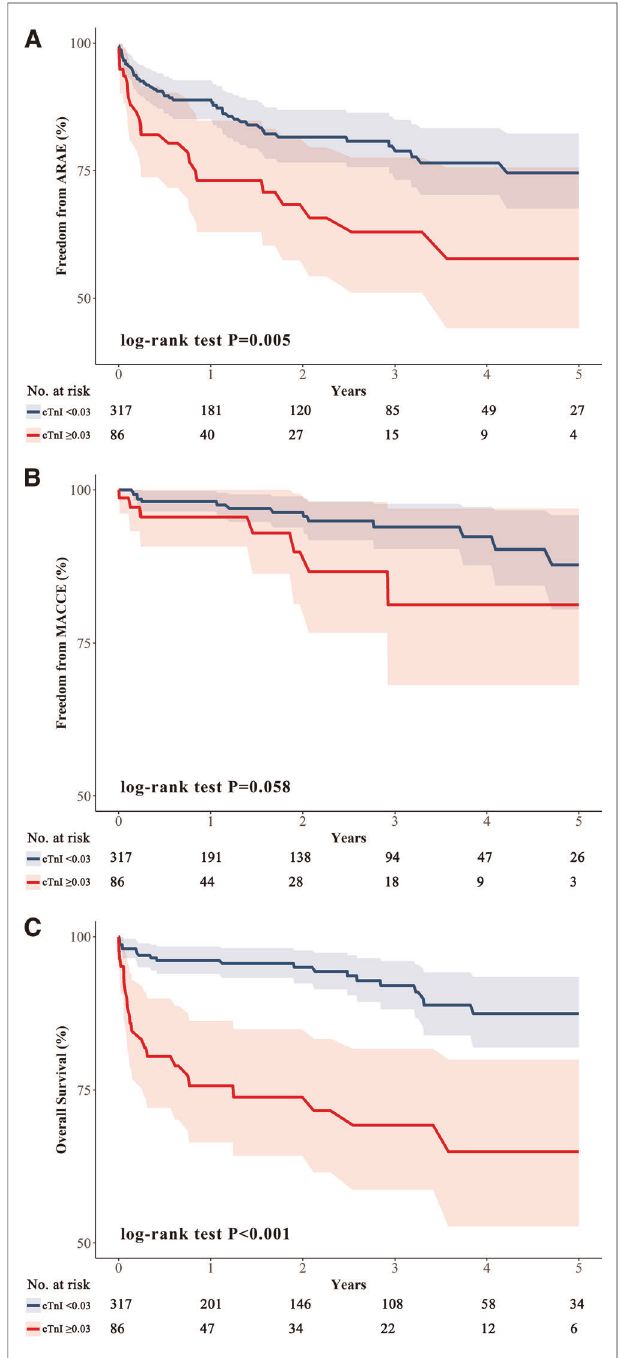
FIGURE 2 | Kaplan – Meier curves. Survival curves for aTBAD patients after TEVAR, strati fi ed with cTnI <0.03 ng/mL and ≥ 0.03 ng/mL. The differences in outcomes between the two groups were estimated by using the log-rank test. ( A ) The freedom from 5-year ARAEs between the two groups [cTnI( − ) vs cTnI (+), 74.6% (67.6 – 82.3) vs 57.7% (44.1 – 75.6), p =0.005]; ( B ) The freedom from 5-year MACCEs between the two groups [cTnI( − ) vs cTnI(+), 87.8% (80.4 – 95.8) vs 81.2% (68.1 – 96.9), p =0.058]; ( C ) The overall survival rates between the two groups [cTnI( − ) vs cTnI(+), 87.5% (81.9 – 93.4) vs 64.9% (52.7 – 79.9), p <0.001]. aTBAD, acute type B aortic dissection; TEVAR, thoracic endovascular aortic repair; cTnI, cardiac troponin I; ARAEs, aortic-related adverse